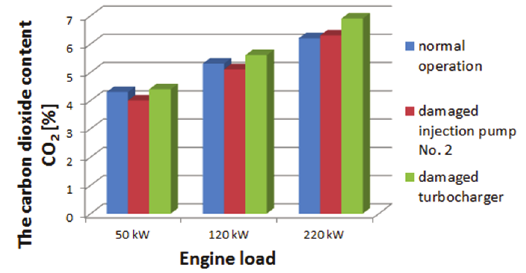
Fig. 8. The influence of engine load on the content of carbon dioxide CO 2 [%] indicated by the analyzer for various engine